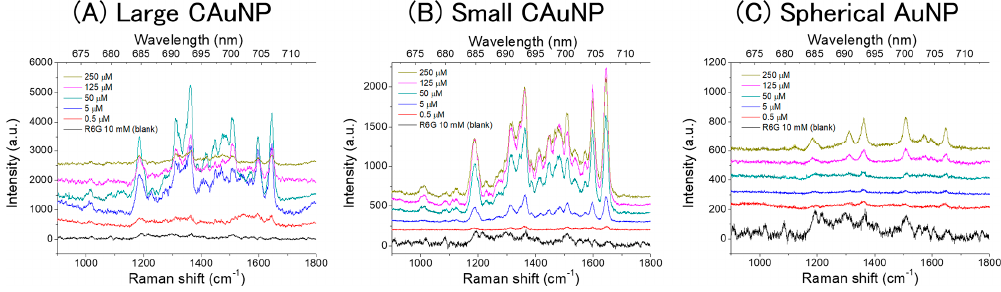
Figure 3. Raman scattering of R6G in the dispersions of CAuNPs and spherical AuNPs. ( A ) large CAuNP, ( B ) small CAuNP, and ( C ) spherical AuNP.